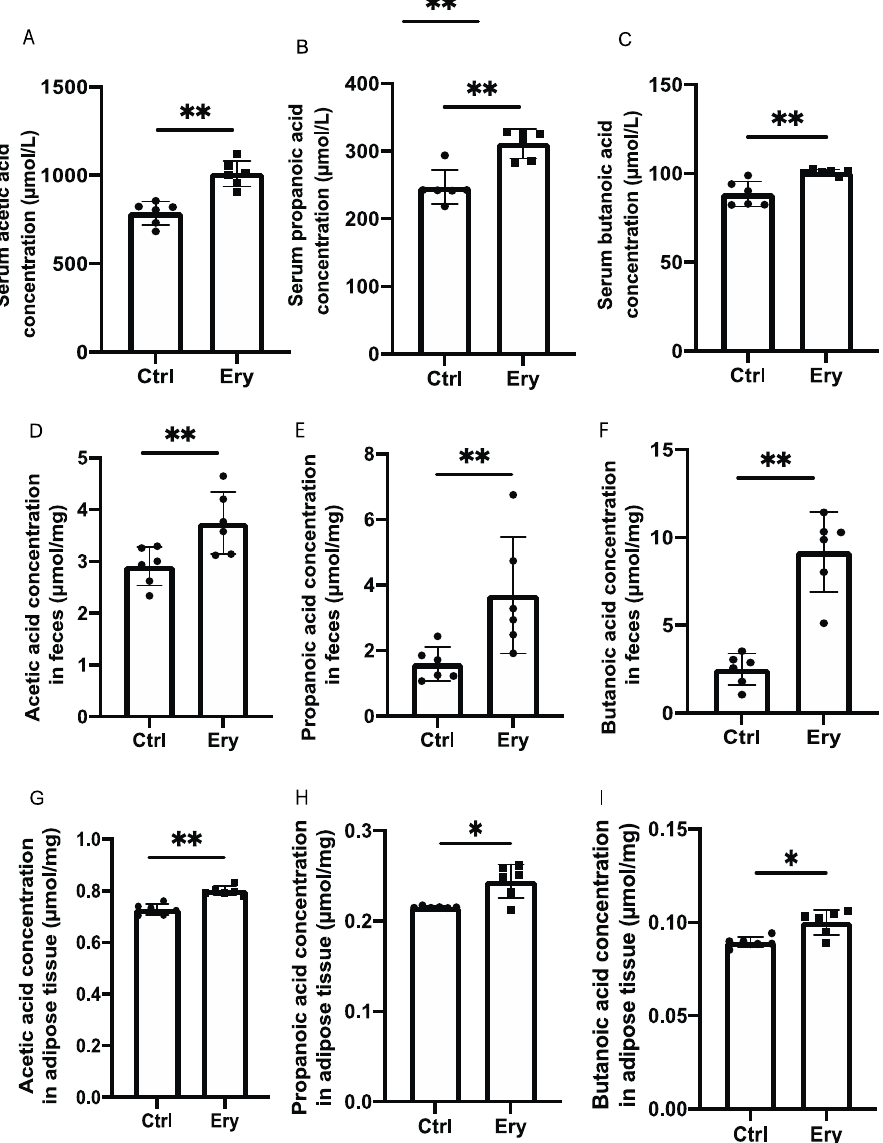
Figure 4. Erythritol administration increased short-chain fatty acid concentrations in the serum, feces, and white adipose tissue. ( A ) Serum acetic acid concentration ( µ mol/L) ( n = 6). ( B ) Serum propanoic acid concentration ( µ mol/L) ( n = 6). ( C ) Serum acetic acid concentration ( µ mol/L) ( n = 6). ( D ) Acetic acid concentration in feces ( µ mol/mg) ( n = 6). ( E ) Propanoic acid concentration in feces ( µ mol/mg) ( n = 6). ( F ) Butanoic acid concentration in feces ( µ mol/mg) ( n = 6). ( G ) Acetic acid concentration in white adipose tissue ( µ mol/mg) ( n = 6). ( H ) Propanoic acid concentration in white adipose tissue ( µ mol/mg) ( n = 6). ( I ) Butanoic acid concentration in white adipose tissue ( µ mol/mg) ( n = 6). Data have been represented in terms of mean ± SD values. * p < 0.05, ** p < 0.01, using an unpaired t -test.